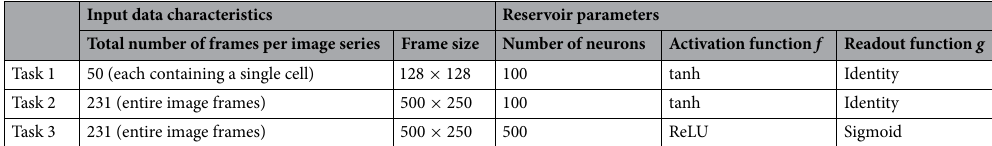
Table 1. Summary of the characteristics of the input data used in the present study and the chosen reservoir parameters for individual tasks.